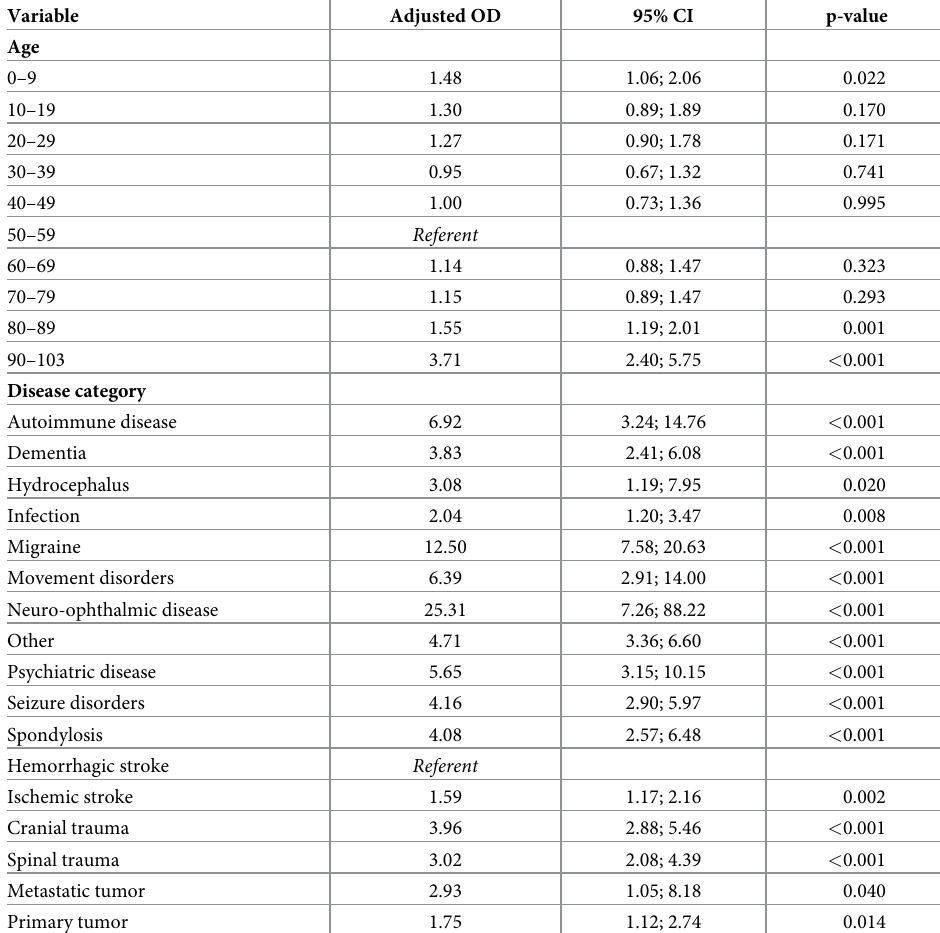
Table 2. Probability of potentially avoidable transfers.